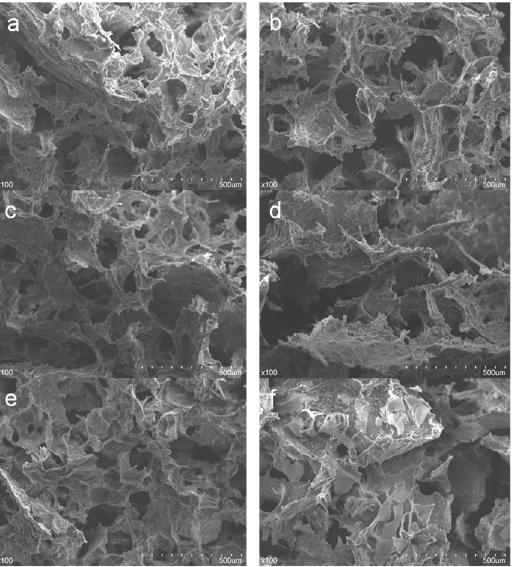
Figure 2. SEM images of the aerogels with different starch content ( a : S 0 CA, b : S 5 CA, c : S 10 CA, d : S 15 CA, e : S 20 CA, f : S 25 CA).